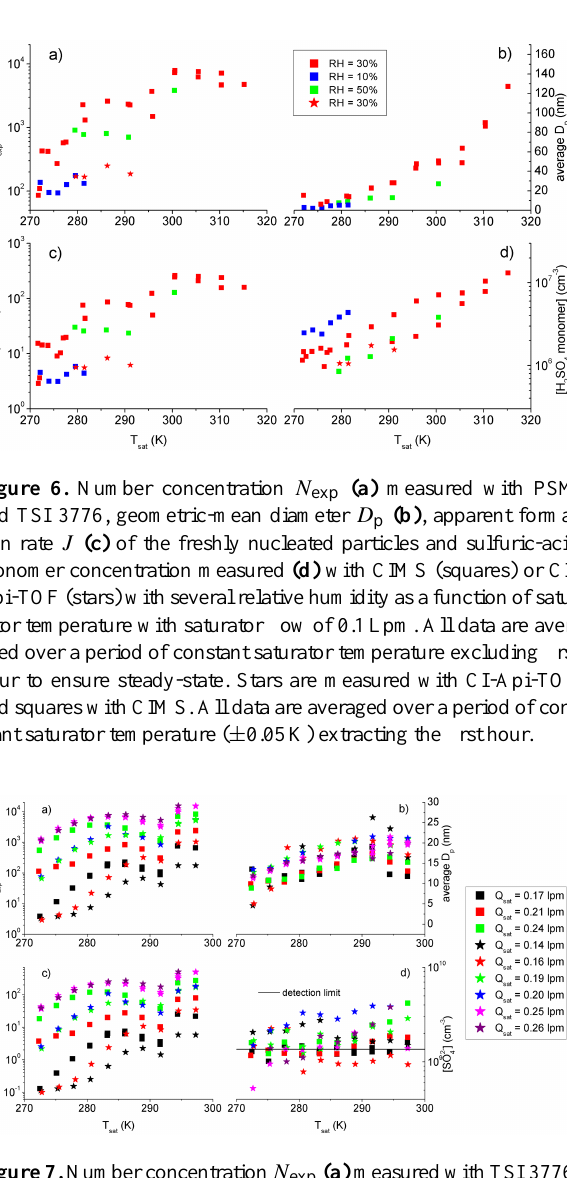
Figure 7. Number concentration N exp (a) measured with TSI 3776, geometric mean diameter D p (b) , formation rate J (c) of the freshly nucleated particles and total-sulfate concentration from MARGA (d) with detection limit of MARGA with several different saturator flow rates as a function of saturator temperature. Squares represent measurements under dry conditions, stars are measured with RH of ∼ 30%. All data are averaged over a period of constant saturator temperature ( ± 0.05K) extracting the first